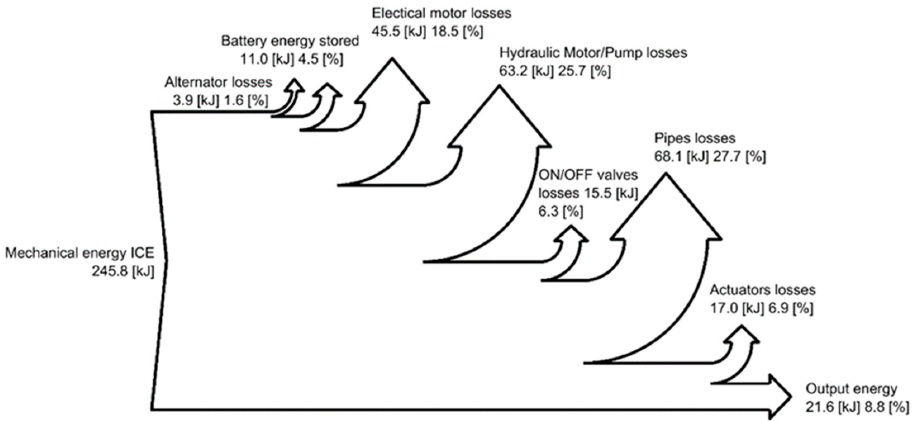
Figure 15. Sankey diagram for the digging duty cycle—DDH with pipes.